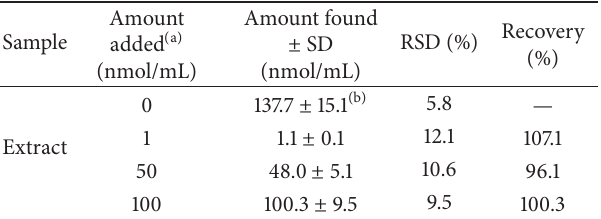
Table 1: Validation data.